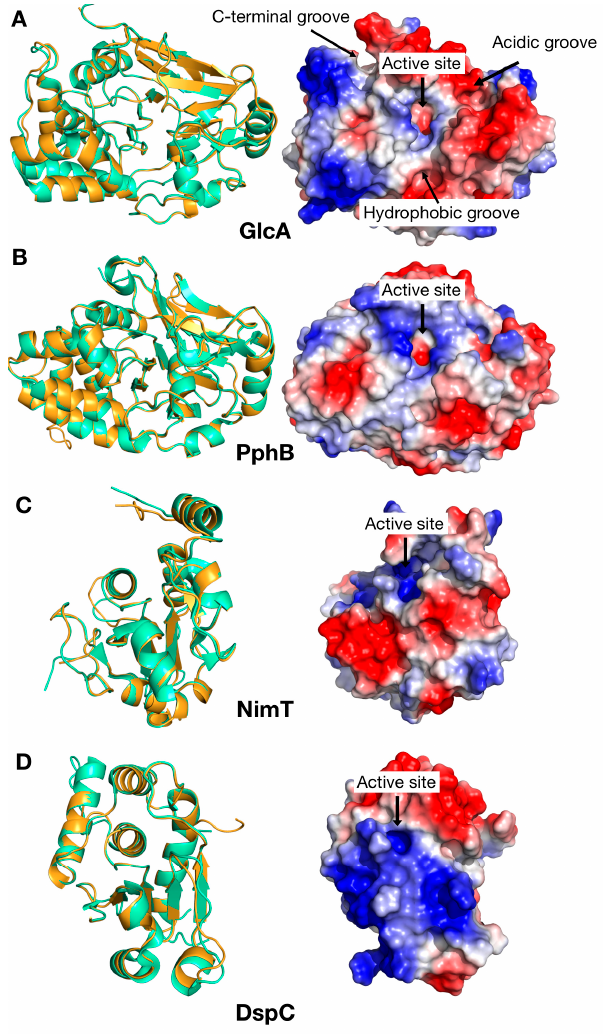
Figure 2. Homology models for the catalytic domains of the AfPPases. ( A ) GlcA model. ( B ) PphB model. ( C ) NimT model. ( D ) DspC model. Ribbon diagrams are shown on the left—orange for the AfPPases, green for the template. Electrostatic surface representations are shown on the right. Active sites are labelled for all phosphatase catalytic domains. Significant sites defined for the human protein phosphatase 1 (hPP1) are also labelled in ( A ).